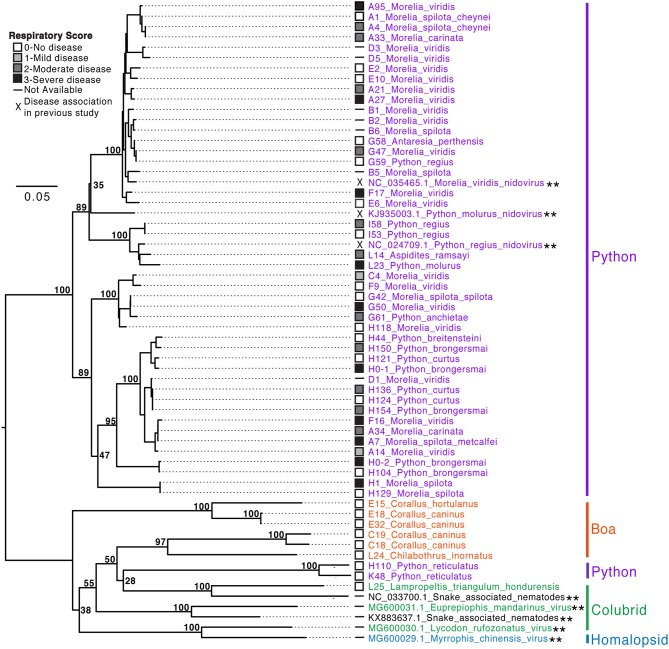
Serpentovirus phylogeny reveals implications regarding species susceptibility to infection and disease. Snake IDs are indicated by collection letter (A–L) and number followed by genus and species. Snake families are indicated to the right: Python (Pythonidae, purple), Boa (Boidae, orange), Colubrid (Colubridae, green), and Homalopsid (Homalopsidae, blue). Reference sequences identified in previous studies and available in GenBank (double asterisks: **) are indicated by accession number followed by the genus and species of the host, except snake-associated nematode viruses in which the host species was unknown. Nucleotide sequences (467 basepairs; ORF1B) aligned and analyzed with PhyML with HKY85 substitution model and 1,000 bootstrap replicates; bootstrap values (%) included at major nodes. The tree was semi-subjectively rooted, this was partially based on protein alignments of ORF1B of serpentovirus reference sequences in GenBank and partially to highlight differences between the python-only clade and more divergent viral sequences of boas, colubrids, homalopsids, and reticulated pythons; a definitive monophyletic clade of these divergent viruses is poorly supported by bootstrap values and should not be interpreted as such. Short sequences of the ORF1B detected during the study and used to generate this phylogeny were deposited in GenBank (MN117077-MN117130).